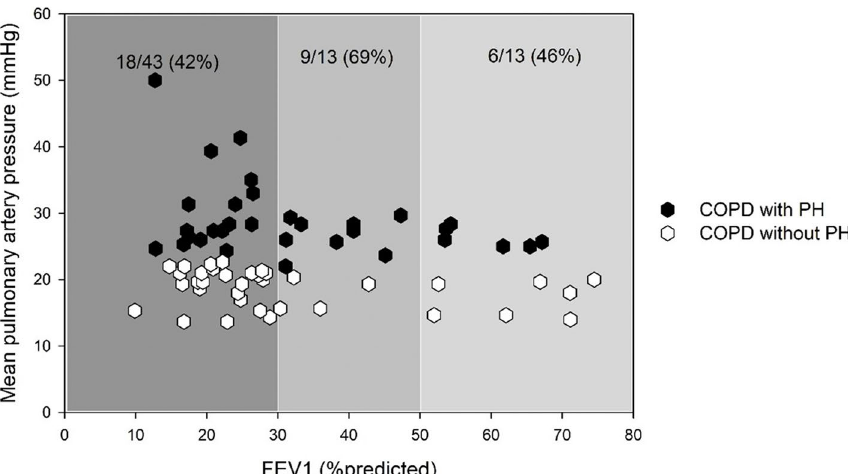
Fig. 1 Distribution of mean pulmonary artery pressure (mPAP, mmHg) across the range of FEV 1 (%predicted) in patients with COPD ( n Resting pulmonary hypertension (PH) was present in 46% of patients with moderate airflow obstruction (i.e., FEV 1 : 50–79%predicted), 69% of those with severe airflow obstruction (i.e., FEV 1 : 30–49%predicted), and in 42% of patients with very severe airflow obstruction (i.e., FEV 1 < 30%predicted). The proportion of patients with COPD who had resting PH did not differ across the range of airflow obstruction severity as determined by FEV 1 (χ 2 3.01, P 0.22). COPD, chronic obstructive pulmonary disease; FEV 1 , forced expiratory volume in 1 s = =